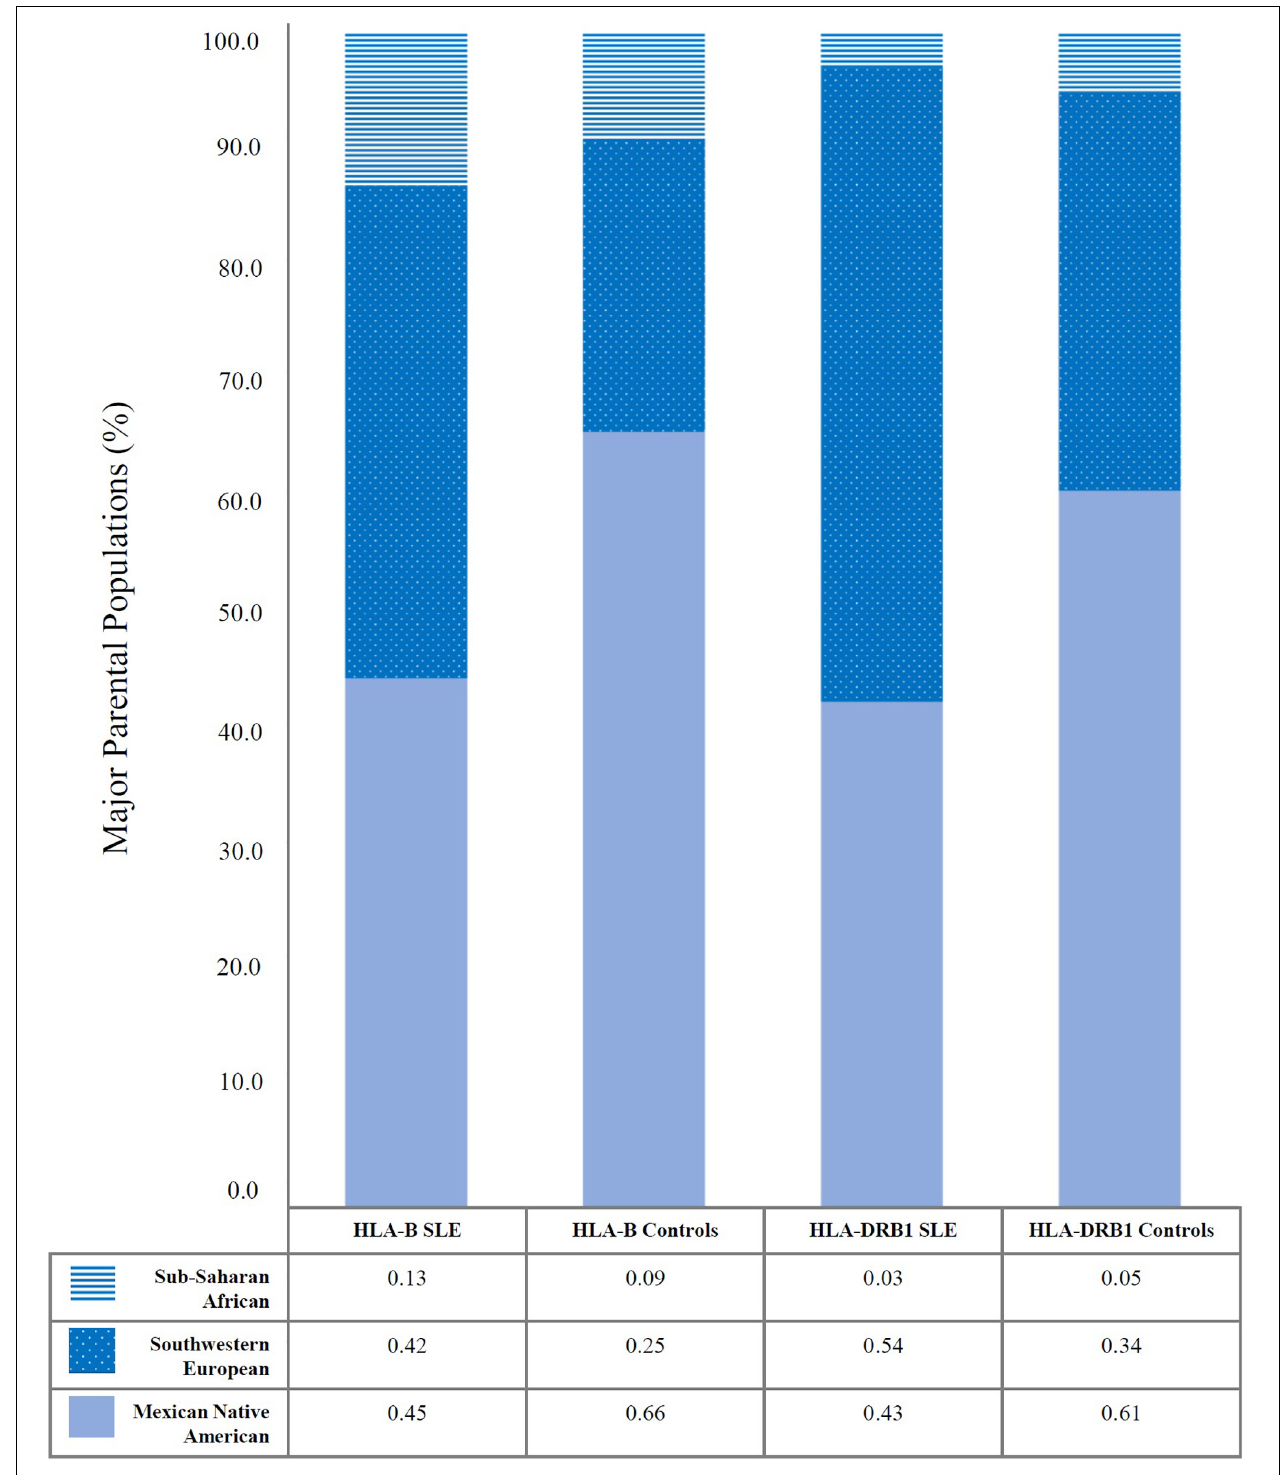
FIGURE 1 | Ethnic admixture estimations revealed differences in Mexican Native American and Southwestern European components between Mexican SLE patients and healthy individuals. It was analyzed by Maximum likelihood approximation using HLA-B and HLA-DRB1. The values presented in Y-axis are the percentages of the main parental populations included (Mexican Native American, Southwestern European, and Sub-Saharan African). The table shows the relative frequencies from 0 to 1. Sub-Saharan African component is shown in blue horizontal lines, Southwestern European component is shown in blue with white points, and Mexican Native American component is shown in solid light blue. Eastern Asian ancestry was minimal, and it is not represented in the graphic.